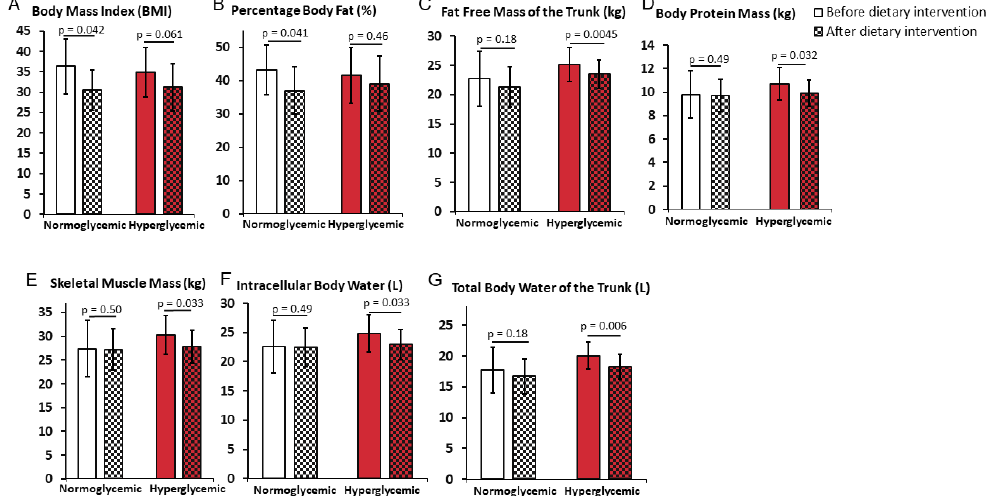
Figure 3. Body mass parameters that differentially changed in normoglycemic or hyperglycemic obese women placed on a 6-month personalized weight reduction consisting of a moderate calorie restriction and moderate exercise individualized to each patient. Body mass index ( A ), percent body fat ( B ), free fat mass of the trunk ( C ), protein ( D ), skeletal muscle mass ( E ), intracellular body water ( F ), and the total body water of the trunk ( G ) were measured at the beginning and the end of the program. Data are mean ± SD. T -test significance: p ≤